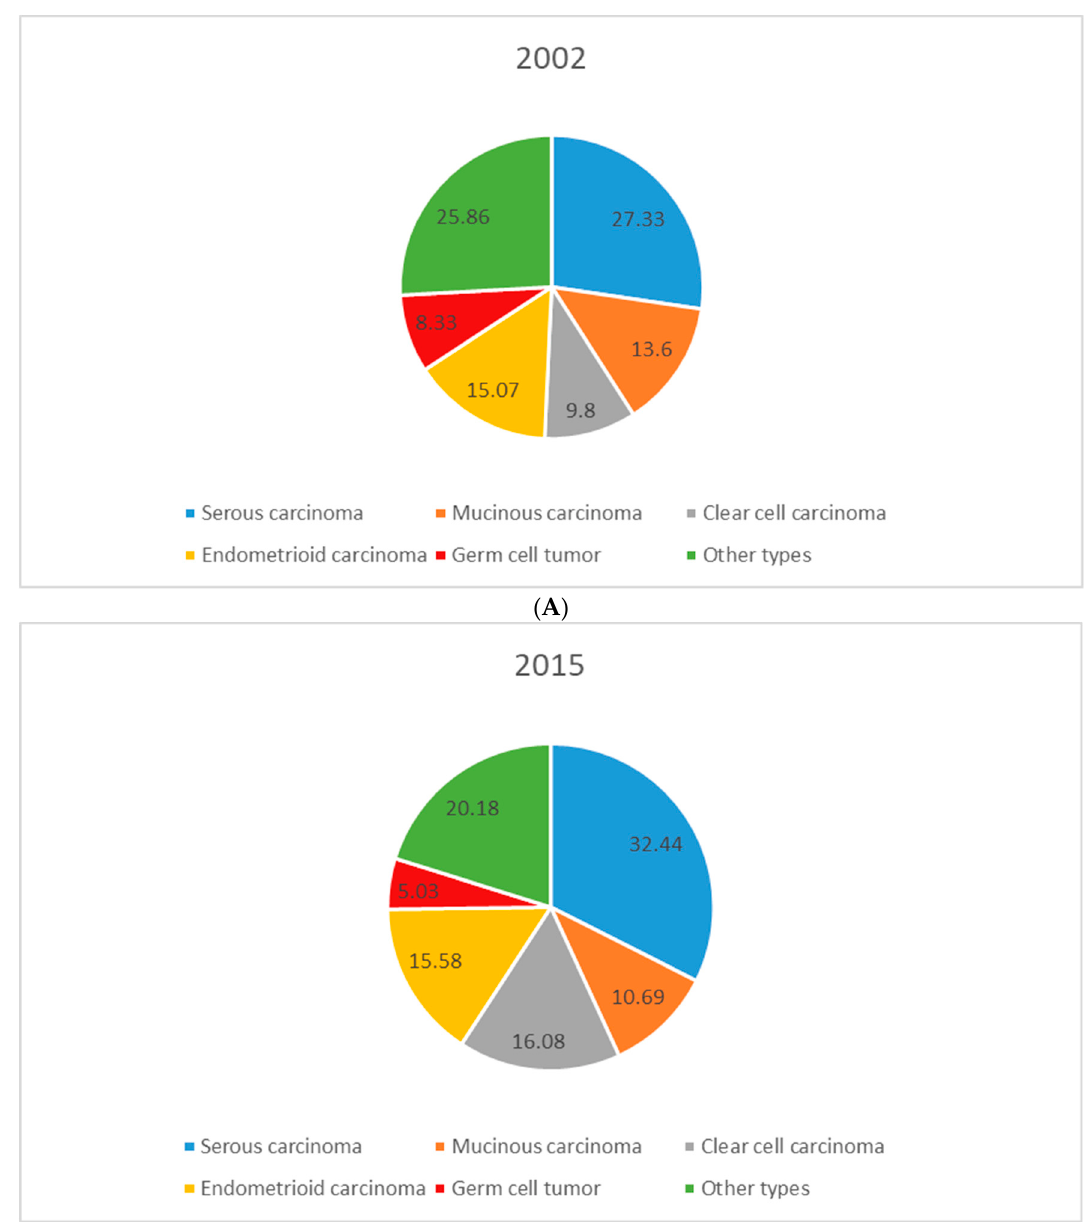
Figure 4. Percentage of different subtypes of ovarian cancer in ( A ) 2002 and ( B ) 2015.